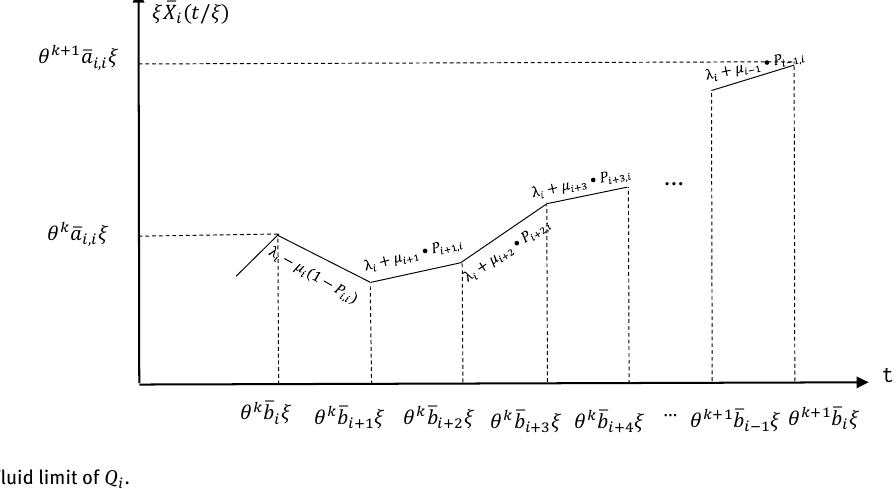
Figure 1: Fluid limit of Q i .